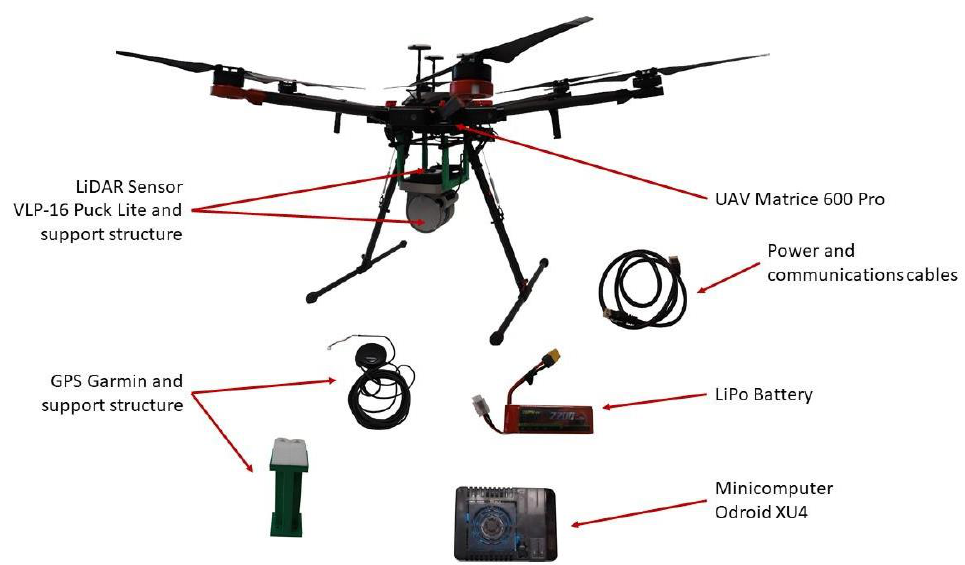
Figure 5. Integration and parts of the LiDAR system with the Matrice 600 Pro